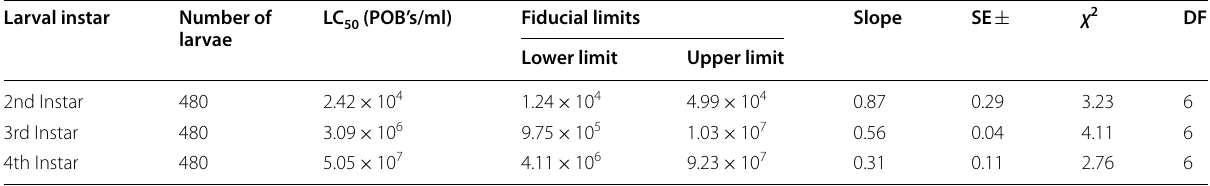
Table 1 Larval bioassay with Spilosoma obliqua Nucleopolyhedrosis virus ( Spob NPV) against 2nd, 3rd and 4th larval instars of Spilosoma obliqua Larval instar Number of larvae